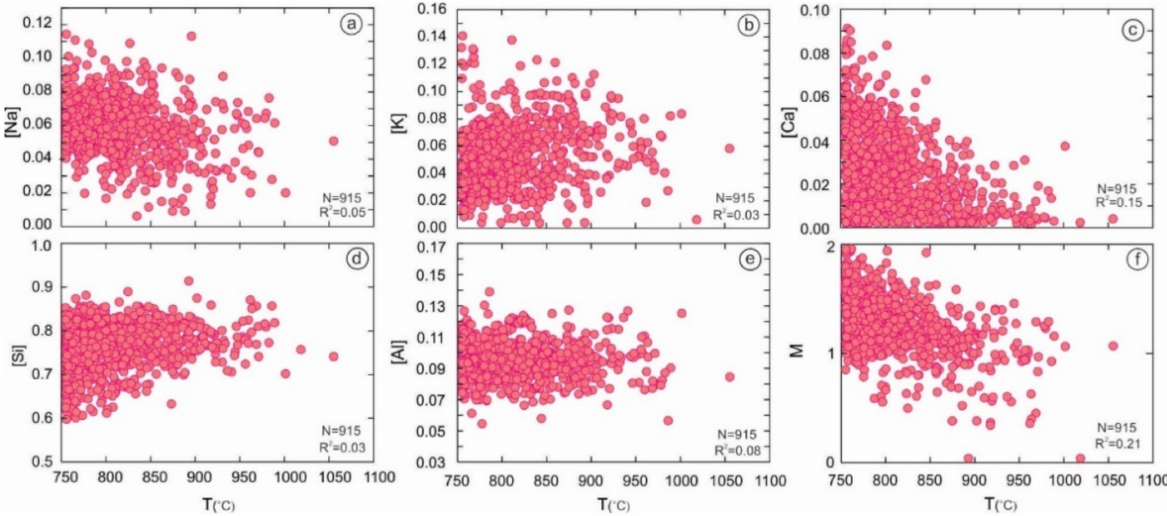
Figure 2. ( a – f ) Plot of the main members of whole rocks M value [(Na + K + 2Ca]/(Si × Al] (cation ratio) versus T Zr for the metaluminous to peraluminous dataset (Temperature is estimated by S20-1); (n = 915 from metaluminous and peraluminous with M < 2 and SiO 2 > 63% wt.%, table, accessed on 29 August